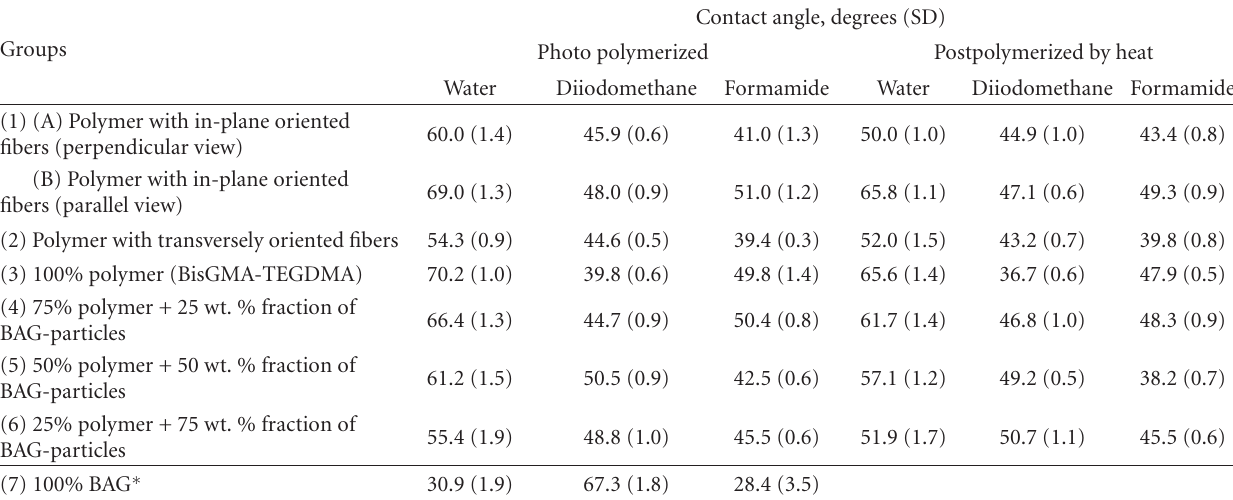
Table 4: Mean values and standard deviations (SD) of contact angle